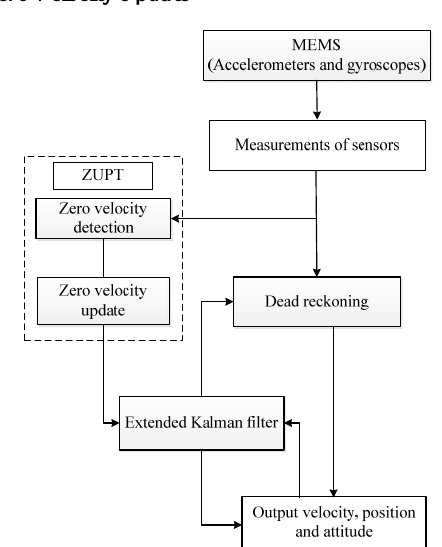
Figure 1. A diagram of zero-velocity-constrained dead- reckoning with MEMS